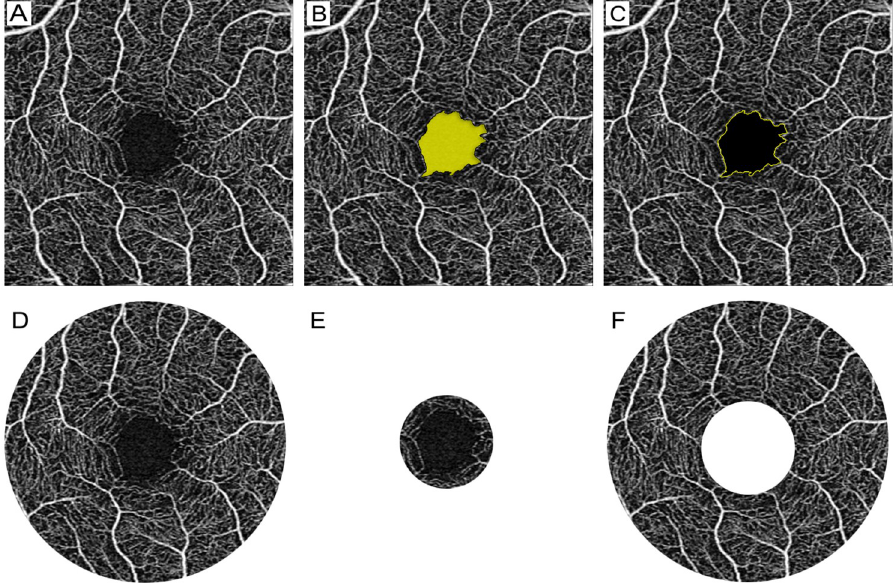
Fig 2. Analysis of OCTA images. (A) Original image of a 3 x 3 mm scan. (B) FAZ area is highlighted in yellow. (C) FAZ circularity is outlined in yellow. (D) The full region used to calculate PD and VLD is a circle with a 3 mm diameter. (E) The center region used to calculate PD and VLD is a circle with 1 mm diameter. (F) The inner region used to calculate PD and VLD is a ring around the center with inner and outer radii of 0.5 and 1.5 mm, respectively.